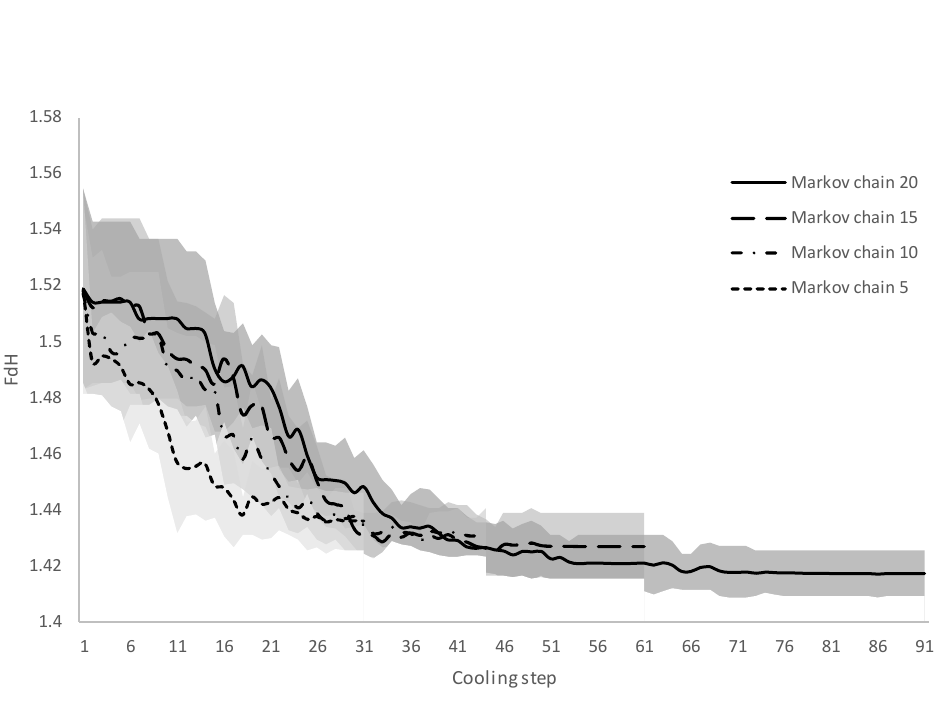
Figure 4. FdH versus cooling step using 105 parallel groups.